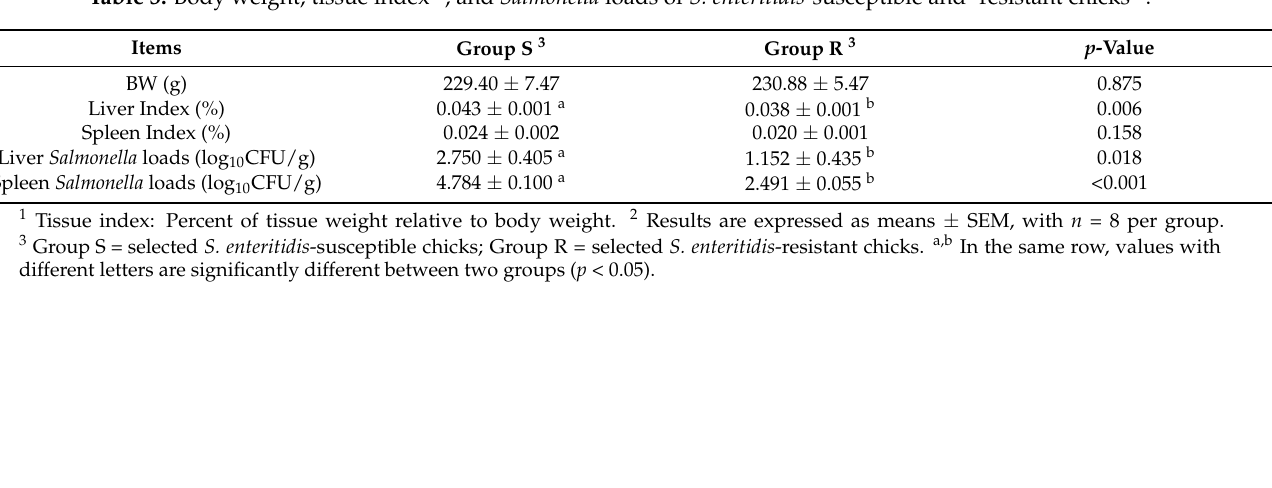
Table 3. Body weight, tissue index 1 , and Salmonella loads of S. enteritidis -susceptible and -resistant chicks 2 . Items